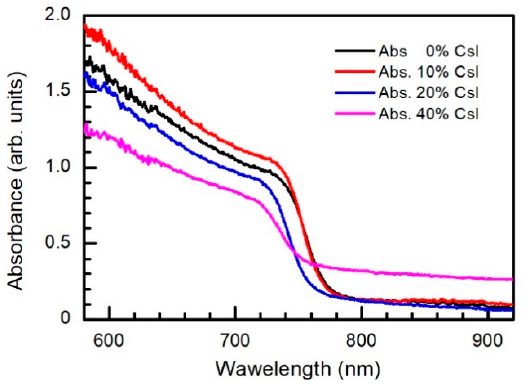
Figure 6. Absorbance spectra of perovskite films with different Cs concentration.